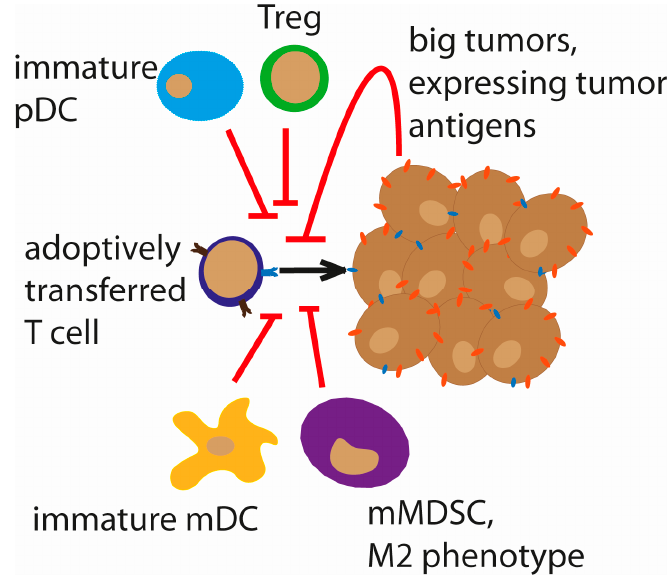
Figure 1. Challenges to adoptive cell therapy (ACT). The fate of adoptively transferred genetically engineered T cells (CAR/TCR) faces several hurdles. The size of the tumor can inversely correlate with the efficacy of ACT. Immature plasmacytoid dendritic cells (pDCs), myeloid DCs (mDCs), Tregs and myeloid-derived suppressor cells (MDSCs), resulting in a general immunosuppressive tumor micromilieu, are also counterproductive to ACT responses.